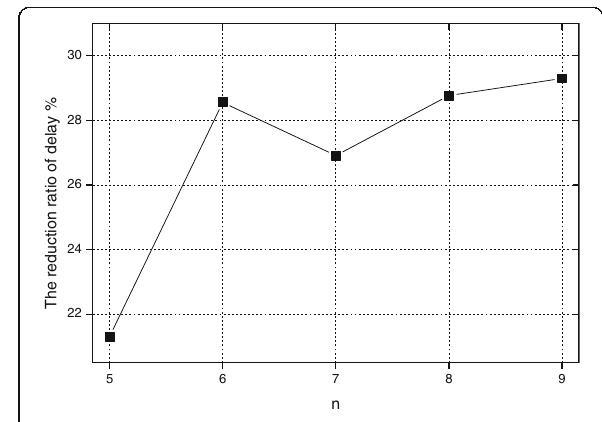
Fig. 40 The delay reduction ratio of UDCNP vs ODCNP (MPSK)